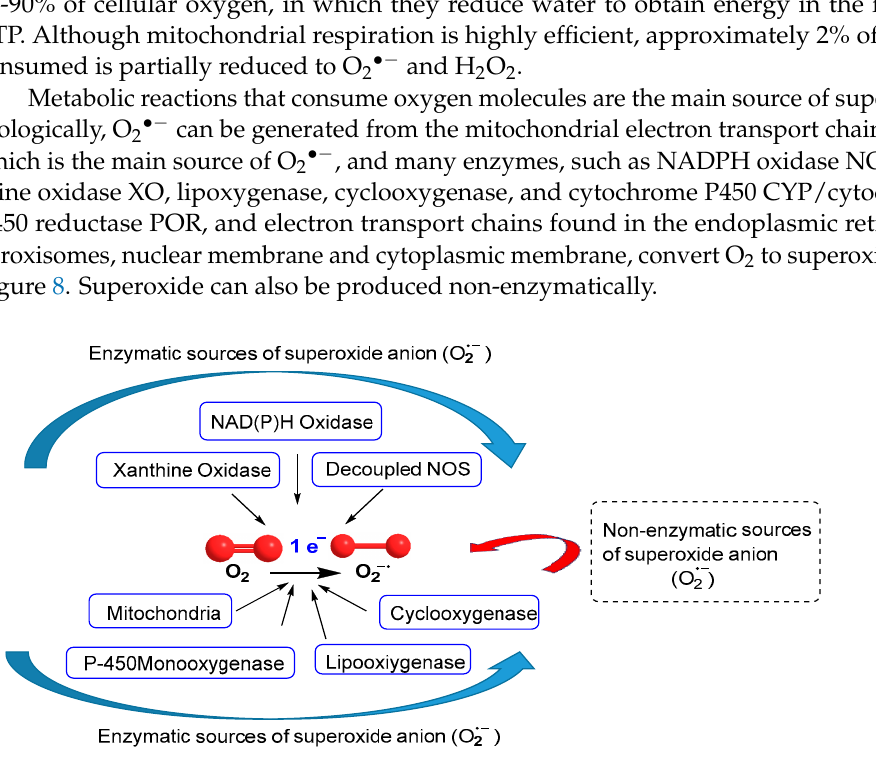
Figure 7. Oxygen reduction to O 2• − .